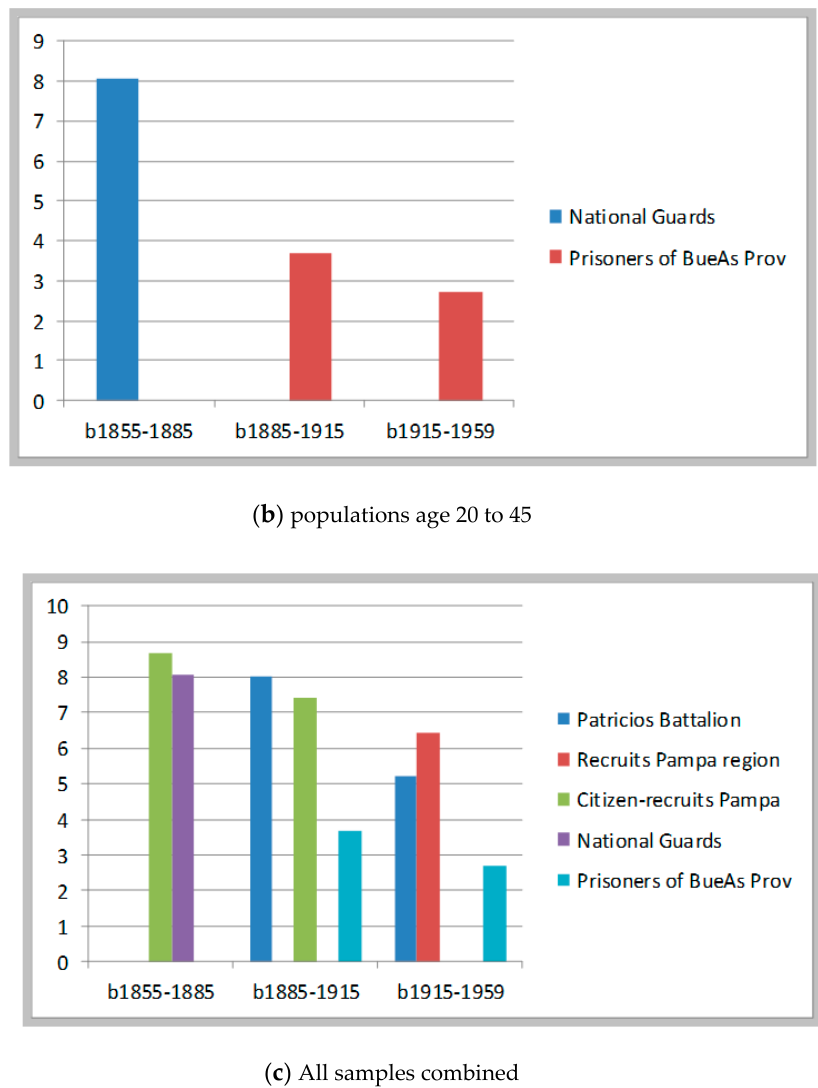
Figure 9. Estimated stunting rate—using 75th height centile as